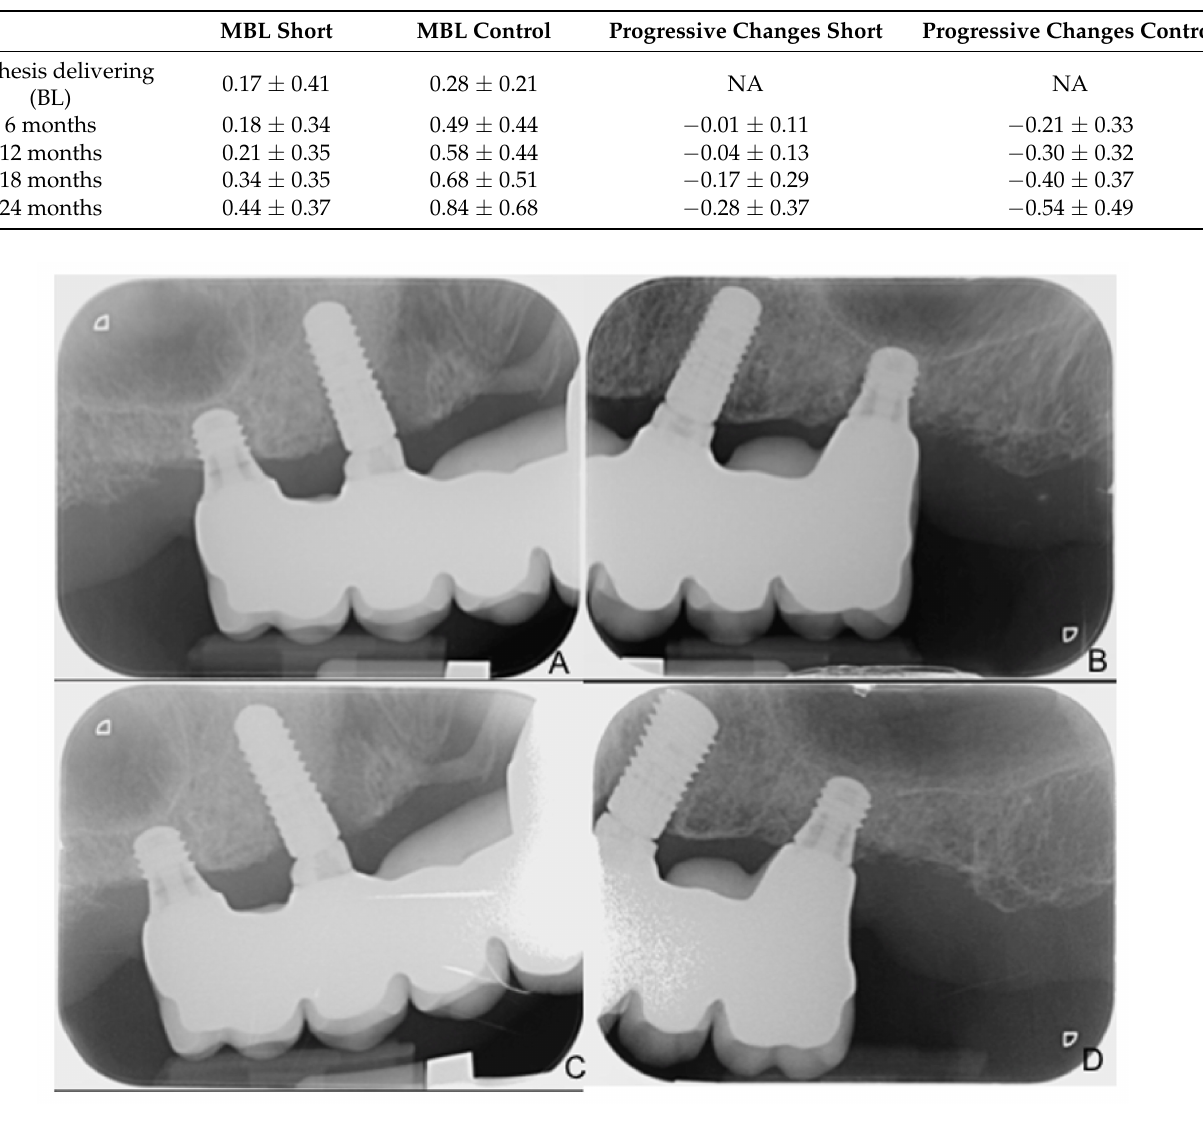
Figure 4. X-rays illustrating the situation of the short implant group immediately after loading ( A , B ), and after 24 months of loading ( C , D